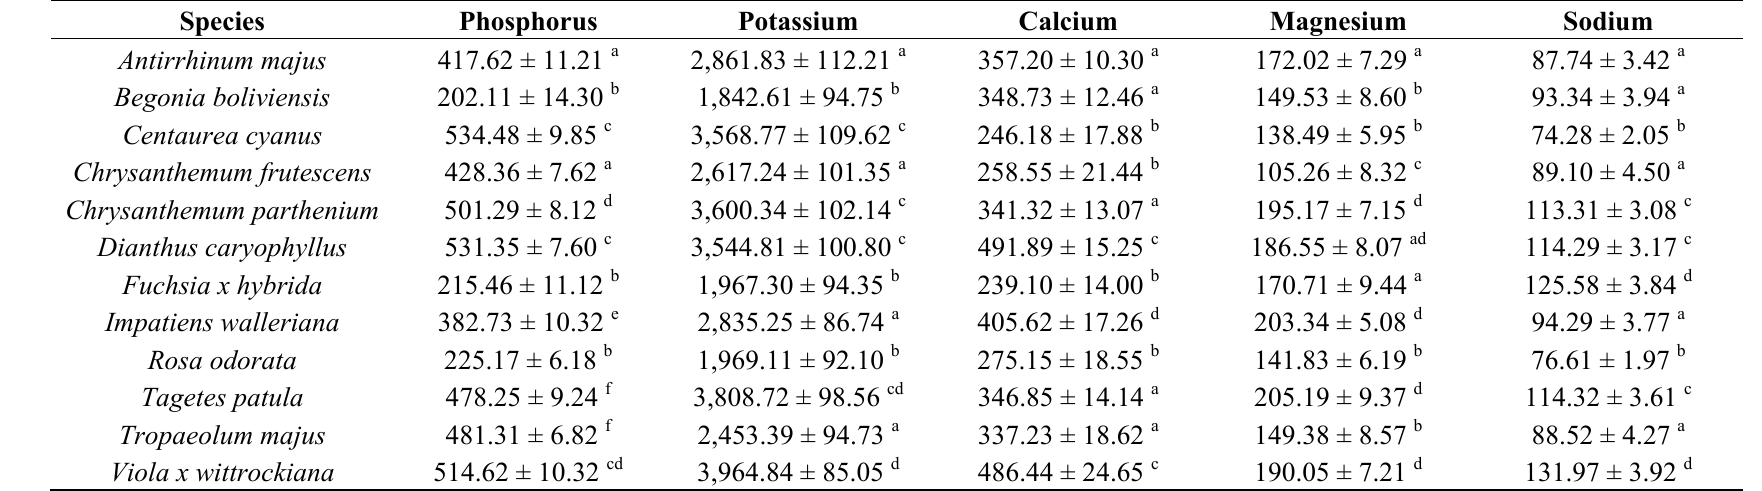
Table 3. Content of macroelements (mg/kg of FM) in 12 species of edible flowers, n = 10. Species Phosphorus Potassium Calcium Magnesium